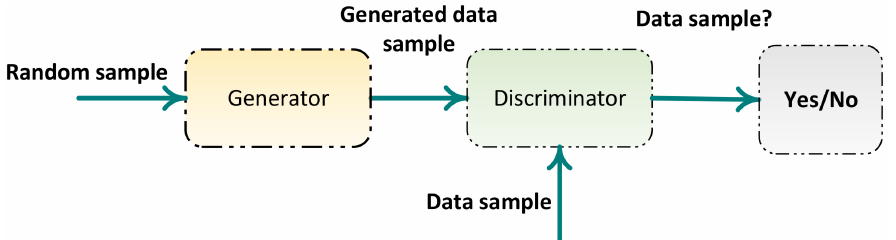
Figure 6. The structure of a GAN